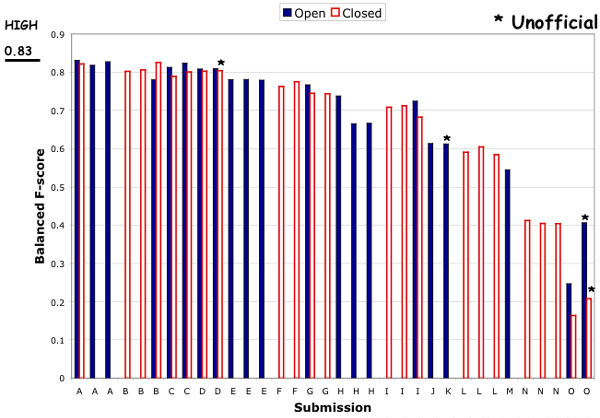
Balanced F-scores of the 40+4 submissions.